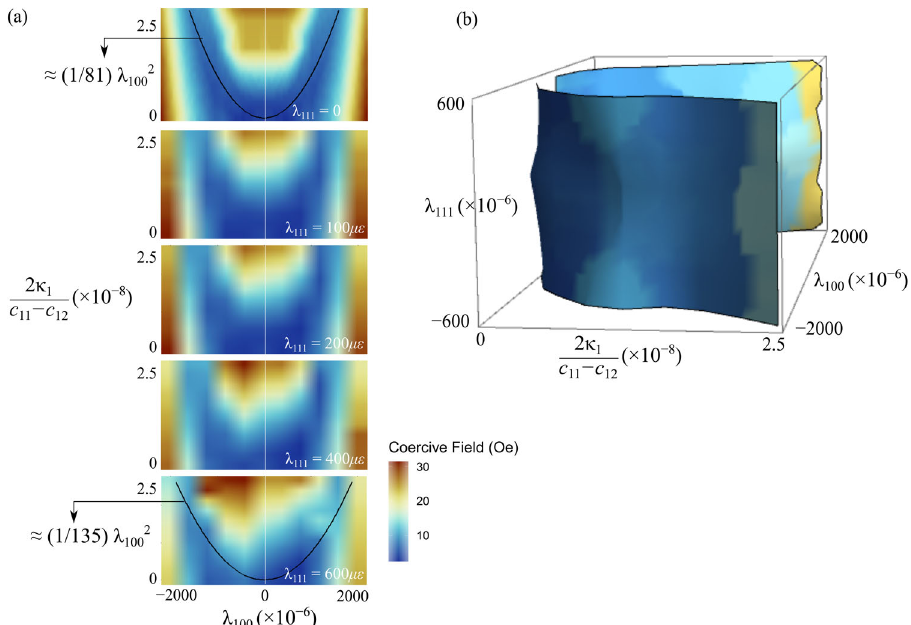
Fig. 3 The coercivity map as a function κ 1 , λ 100 , and λ 111 . a The minimum coercivity is achieved along a parabolic relation, ð c 11 (cid:2) c 12 Þ λ 2 100